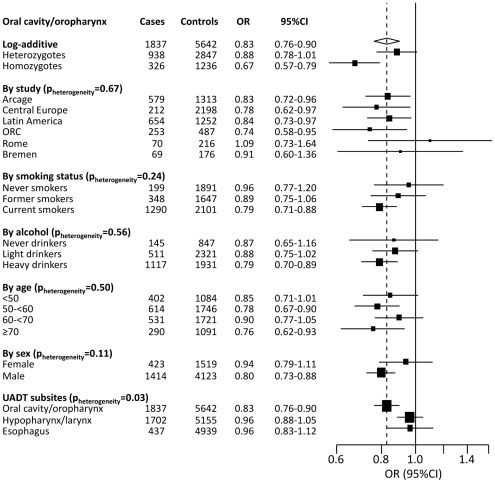
Forest plot showing overall and stratified association results of the rs991316 SNP with oral cancer (oral cavity and oropharyngeal cancer).a) Apart from the OR for CT heterozygotes and TT homozygotes, which were estimated relative the major CC homozygotes, all OR and 95% CIs were estimated using the log-additive model, adjusting for age, gender and center. All subjects from the genome-wide and replication phases with available co-variates were included in this analysis (not generic controls). The overall OR for cancers of oral cavity and oropharynx is shown by the dotted vertical line. b) P for heterogeneity indicates differences in OR between strata and was derived from the Cochran's Q test. c) Never drinkers were subjects that either reported 0 g alcohol intake per day, or reported being never drinker, light drinkers consumed >0 and <6.06 g alc./day, intermediate drinkers consumed >6.06 and <46.3 g alc./day, and heavy drinkers consumed >46.3 g alc./day. d) Hypopharynx, larynx, and esophagus cases were not included in the analyses above.